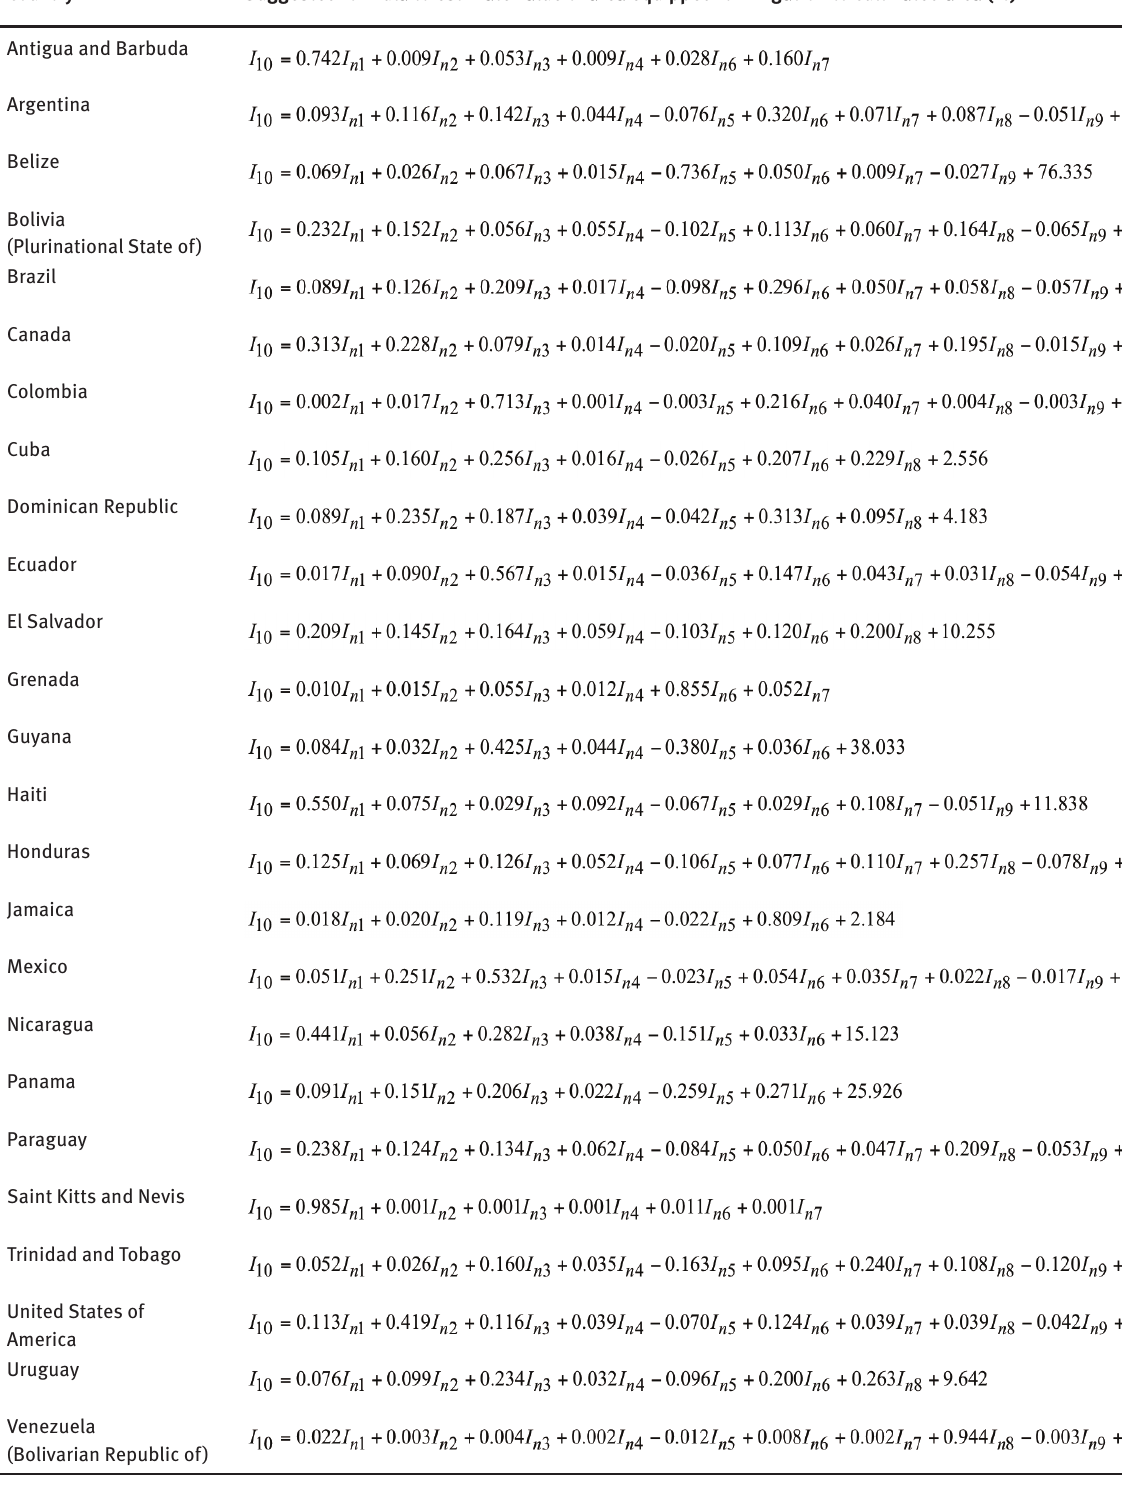
Table 2: Estimated functions using the second method (Eq. 10) for value of area equipped for irrigation to cultivated area in Americas (25 countries), this function is not calculable for Bahamas, Barbados, Chile, Costa Rica, Dominica, Guatemala, Peru, Puerto Rico, Saint Lucia, Saint Vincent and the Grenadines, and Suriname due to very poor irrigation or lack of adequate data Country Suggested formula to estimate value of area equipped for irrigation to cultivated area